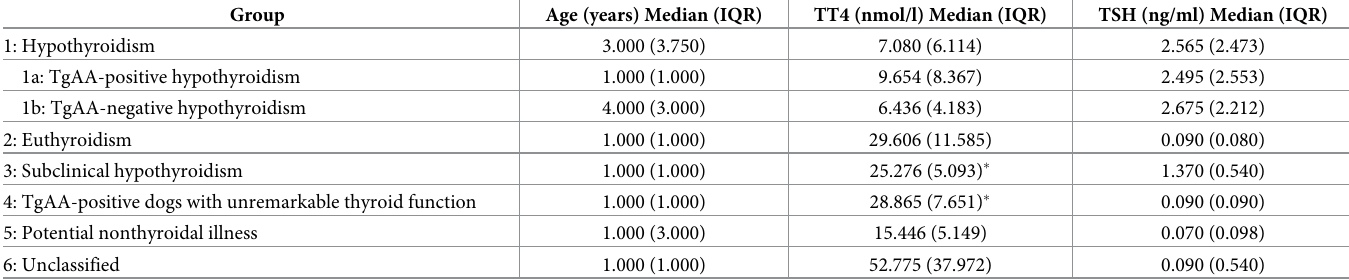
Table 2. Age of the dogs, TT4 and TSH concentrations in the different groups. The data is provided as median and IQR if not normally distributed, and as mean and SD ( � ) if normally distributed.